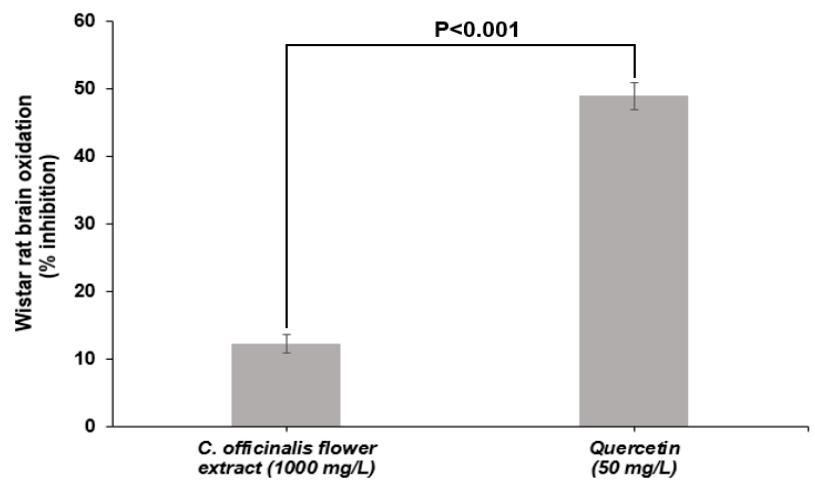
Figure 3. Inhibition of lipid oxidation of Wistar rat brain treated with lyophilized marigold extract ( C. o ffi cinalis ) in comparison to quercetin. Probability value was obtained using unpaired Student t text.